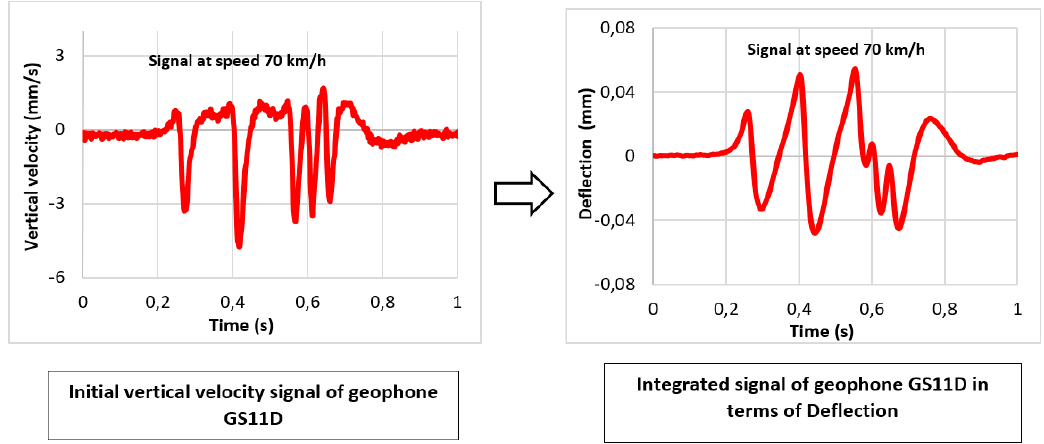
Figure 3. Example of raw and integrated geophone GS11D signal, for a 5-axle truck loading.